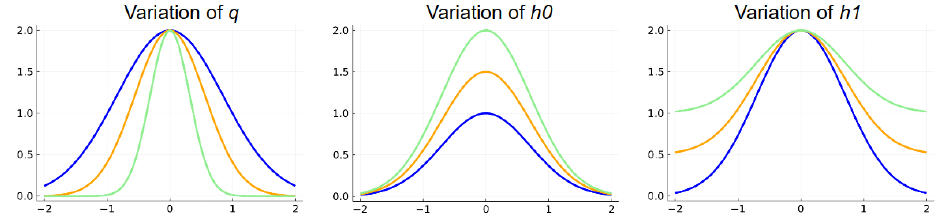
Figure 4. Examples of variations of different parameters of a Gaussian